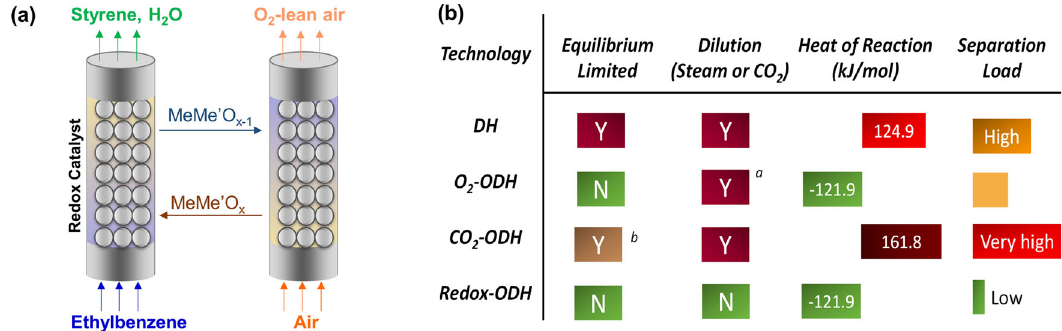
Fig. 1 Schematic and the advantages of redox-ODH. a Schematic illustration of redox-ODH of ethylbenzene. MeMe ′ O x represents a generic redox catalyst. b A comparison between ethylbenzene DH, O 2 -ODH, CO 2 -ODH, and redox-ODH. Green background stands for desirable features. a Steam dilution is necessary to avoid combustion limit. b CO 2 -ODH is still equilibrium limited compared to O 2 - and redox-ODH due to the equilibrium limitation in R-WGS (reverse water-gas-shift).